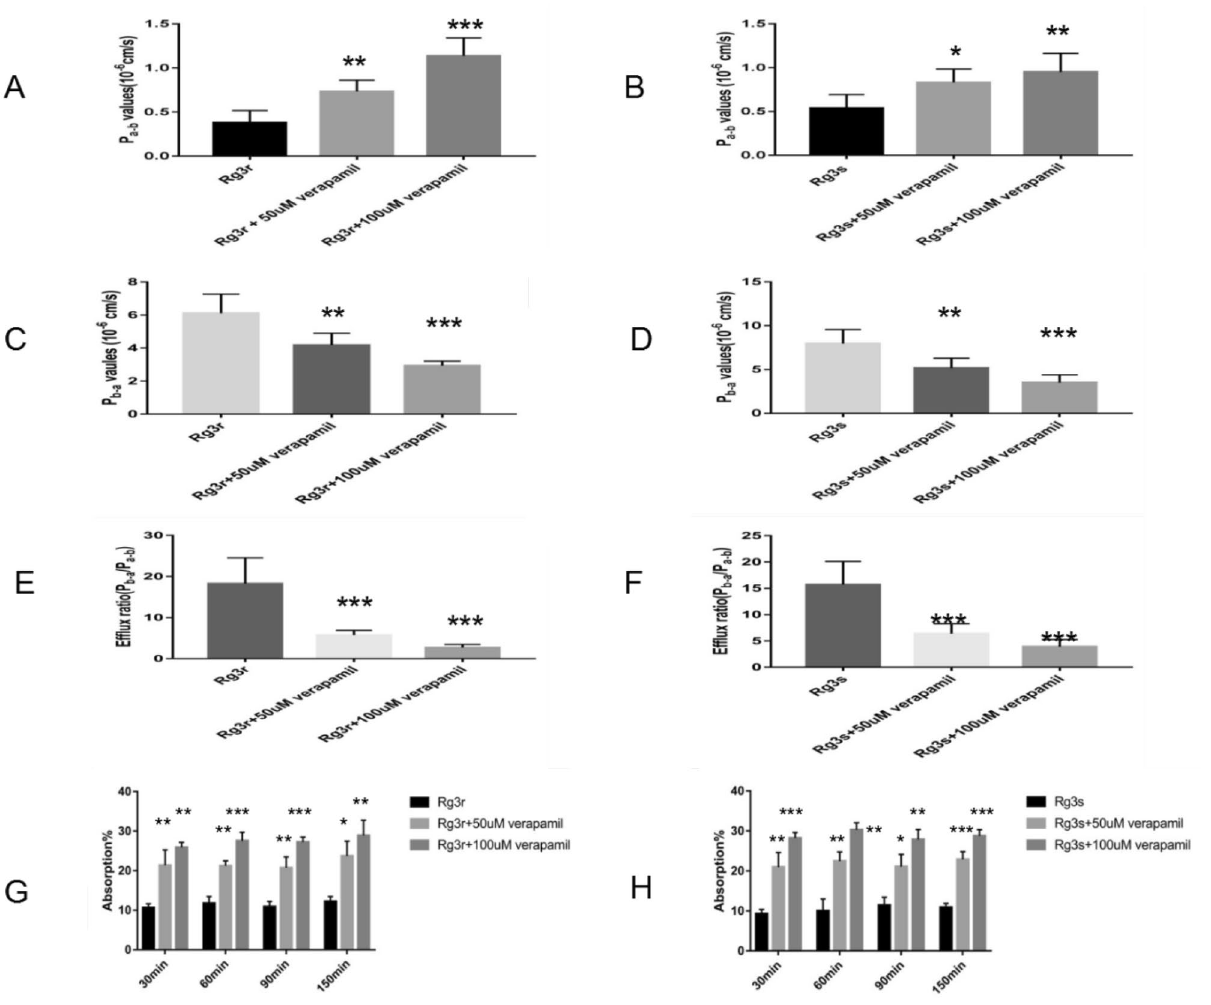
Figure 3. G-Rg3 transcellular transport in the Caco-2 monolayer and intestinal absorption in the rat perfusion assay. ( A ) Pa-b values of G-Rg3r groups in the Caco-2 monolayer. ( B ) Pa-b values of G-Rg3s groups in the Caco-2 monolayer. ( C ) Pb-a values of G-Rg3r groups in the Caco-2 monolayer. ( D ) Pb-a values of G-Rg3s groups in the Caco-2 monolayer. ( E ) Efflux ratio of G-Rg3r groups in the Caco-2 monolayer. ( F ) Efflux ratio of G-Rg3 groups in the Caco-2 monolayer. ( G ) Intestinal absorption percentages of G-Rg3r in the rat perfusion assay. ( H ) Intestinal absorption percentages of G-Rg3s in the rat perfusion assay. Comparisons of permeability and absorption were performed with no verapamil added. The data is presented as the mean ± SD of five independent experiments. * P < 0.05, ** P < 0.01, *** P < DNA adduct level compared to that of B(a)P treatment alone, as shown in Fig. 5F (1.87 ± 0.33 vs. 3.77 ± 0.42 for G-Rg3r, and 1.93 ± 0.48 vs. 3.77 ± 0.42 for G-Rg3s, p < 0.001). Modulatory effect of G-Rg3 on the expression of GST.